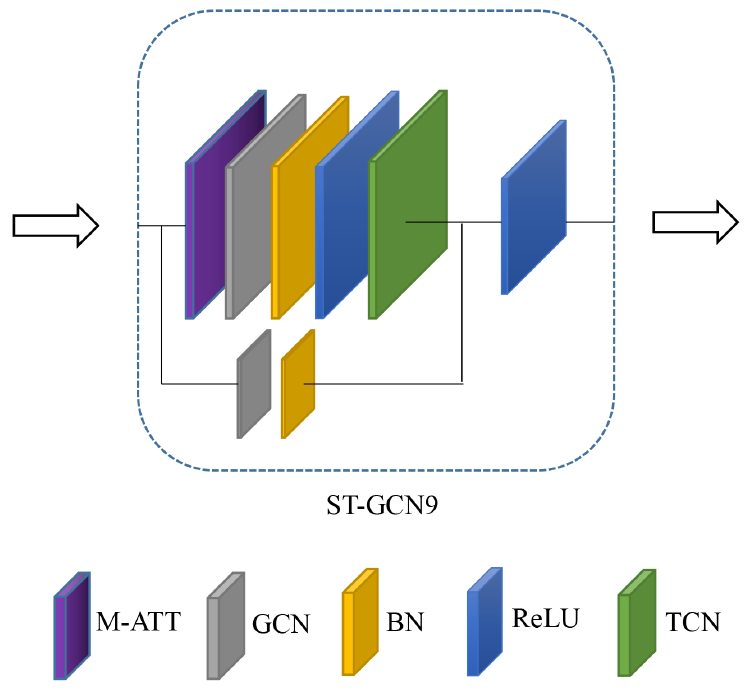
Figure 11. ResNet in improved